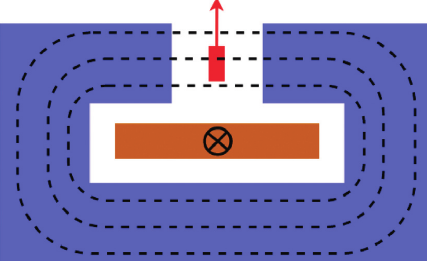
Figure 5: Magnetic field-based current sensing.